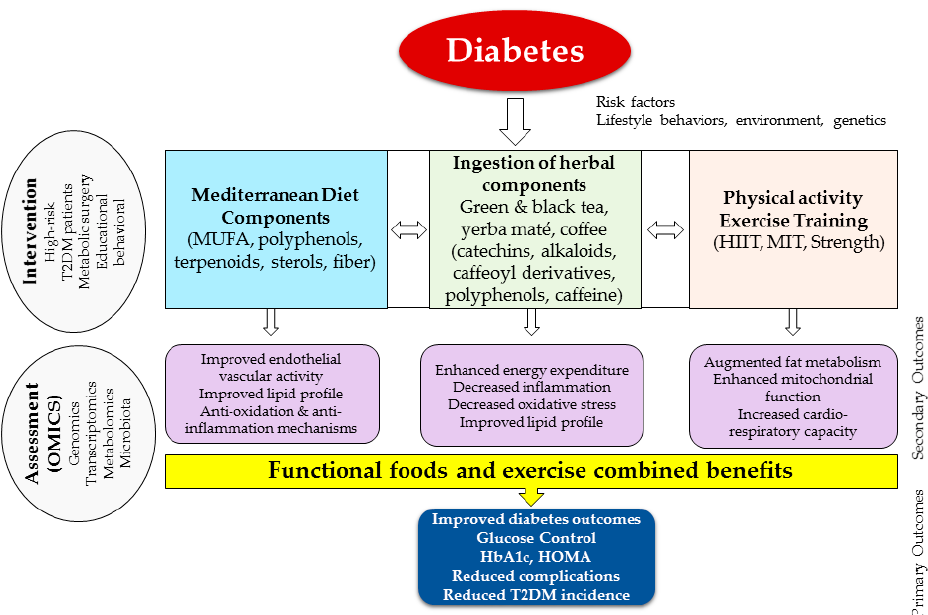
Figure 1. Integration model of functional food in diabetes prevention and management to understand biological processes and improve clinical outcomes. MUFA, monounsaturated fatty acids; HIIT, high intensity interval training; MIT, moderate intensity training; HbA1c, glycosylated hemoglobin A1c; HOMA, homeostatic model assessment; T2DM, type 2 diabetes mellitus.